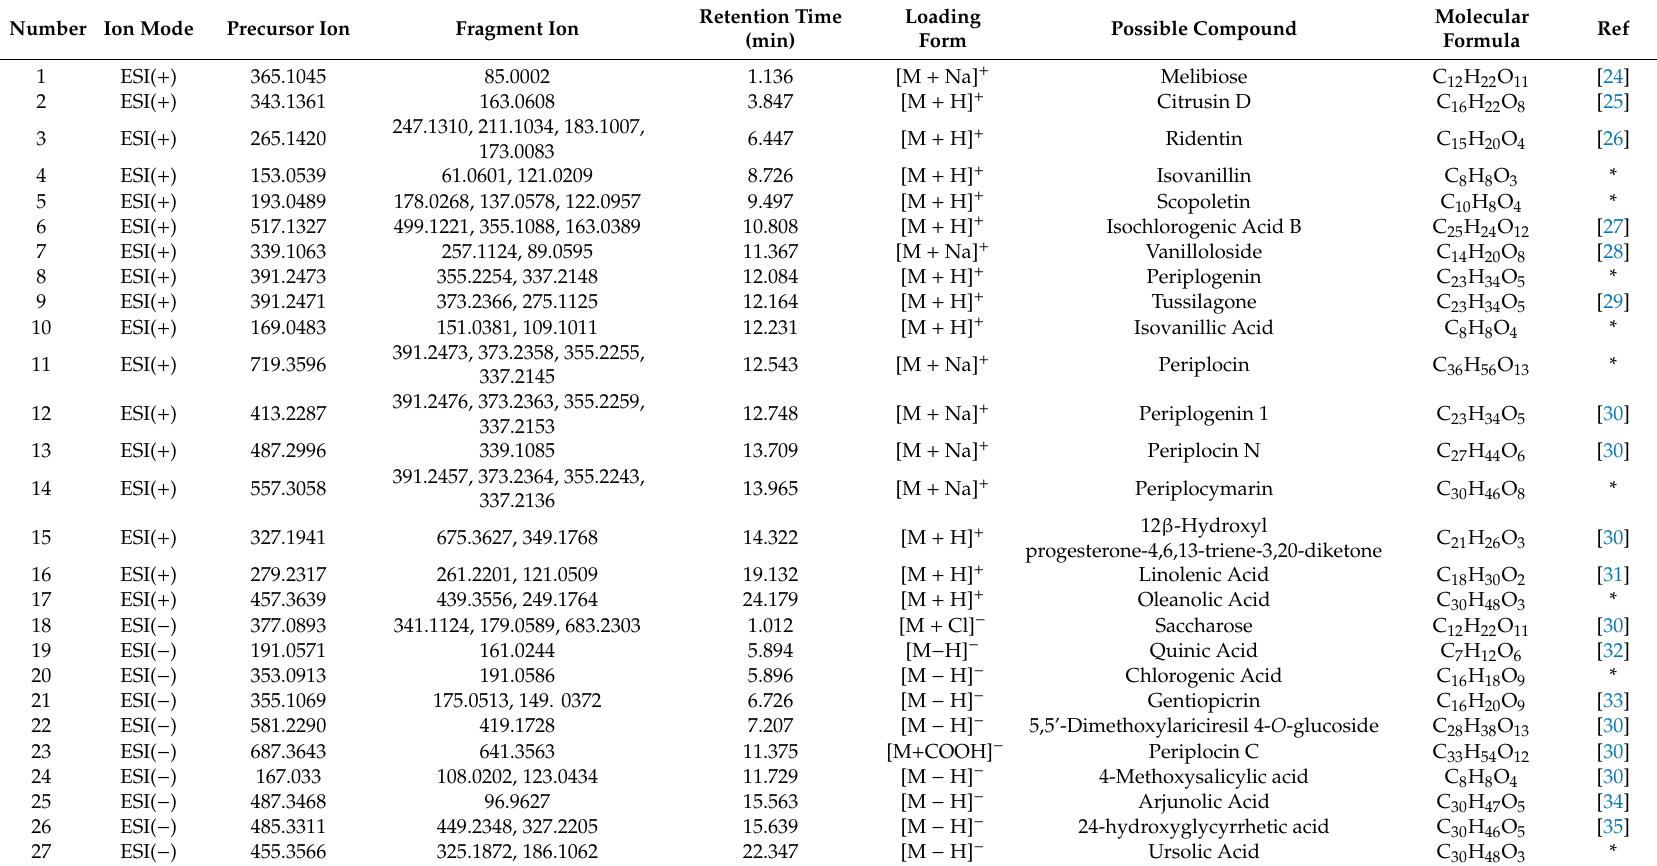
Table 1. Chemical markers identified, based on UPLC-Q-TOF-MS /